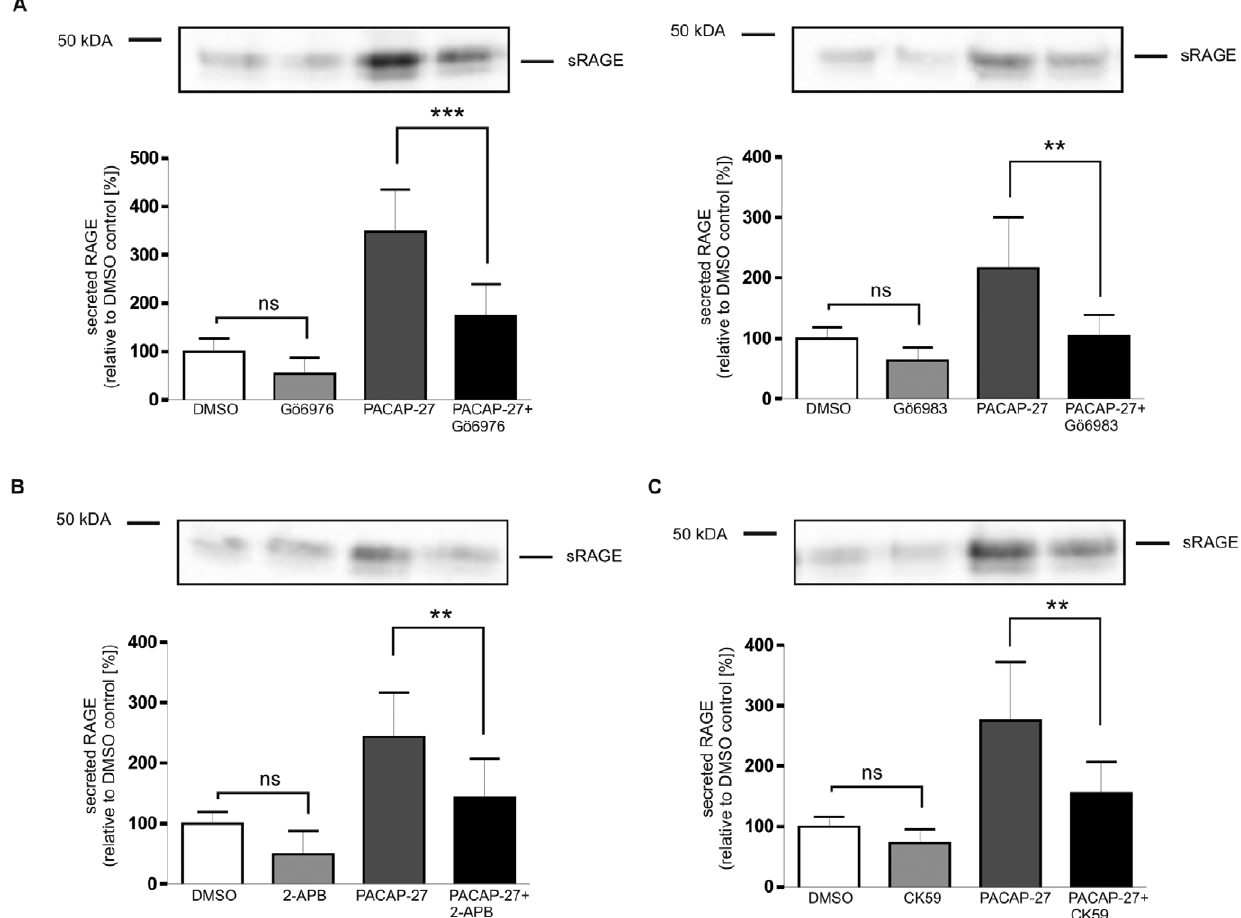
Figure 10. Effect of Ca 2 + on the shedding of RAGE. PAC1/RAGE cells were pre-incubated for 1 h with respective inhibitor and then 300 nM PACAP-27 was added for 2 h. Secreted RAGE in the cell culture supernatant was detected and quantified as described in Figure 1. Shown are the mean effects 6 S.D., significance was determined by the One-way ANOVA test (ns=P . 0.05; ** = P , 0.01; *** = P , 0.001). (A) Effect of protein kinase C inhibitors Go¨6976 and Go¨6983 (both 1 m M); (B) effect of the IP3 receptor modulator 2-APB (75 m M), and (C) effect of the calcium/calmodulin- dependent protein kinase II inhibitor CK59 (20 m M). In all experiments effects of inhibitors were also analyzed in the absence of PACAP stimulation.